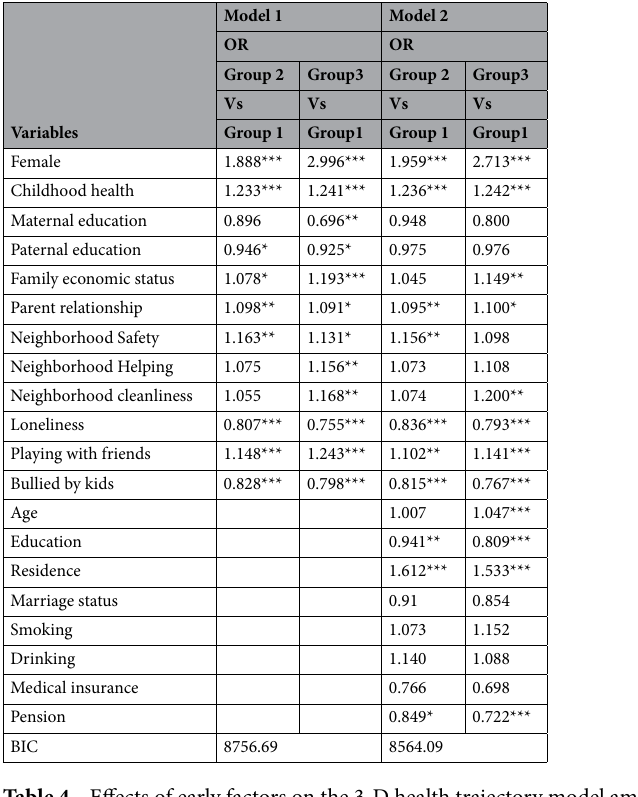
Table 4. Effects of early factors on the 3-D health trajectory model among a sample of older adults survived 7 years in China. OR odds ratio, CI confidence interval, BIC Bayesian Information Criterion. * p < 0.05; ** p < 0.01; *** p <